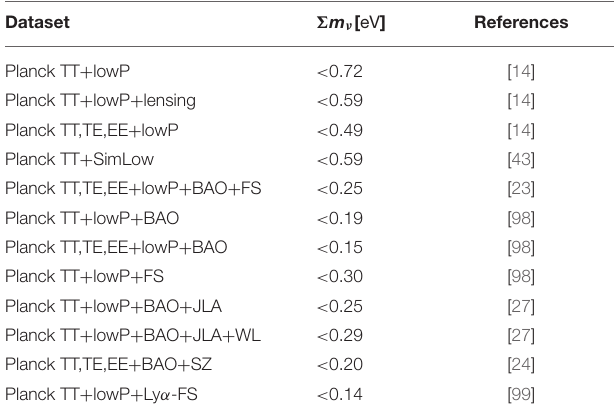
TABLE 1 | Constraints on 6 m ν from different combination of current cosmological data.